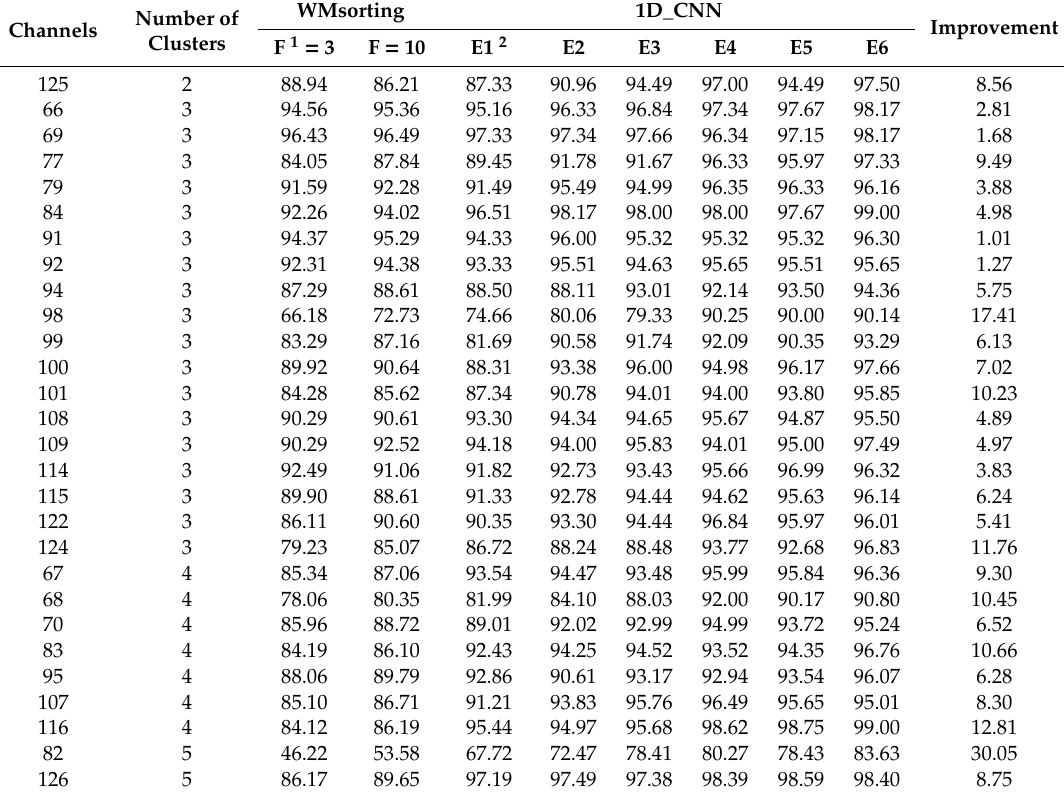
Table 3. Macro_F scores on experimental datasets. 1D,